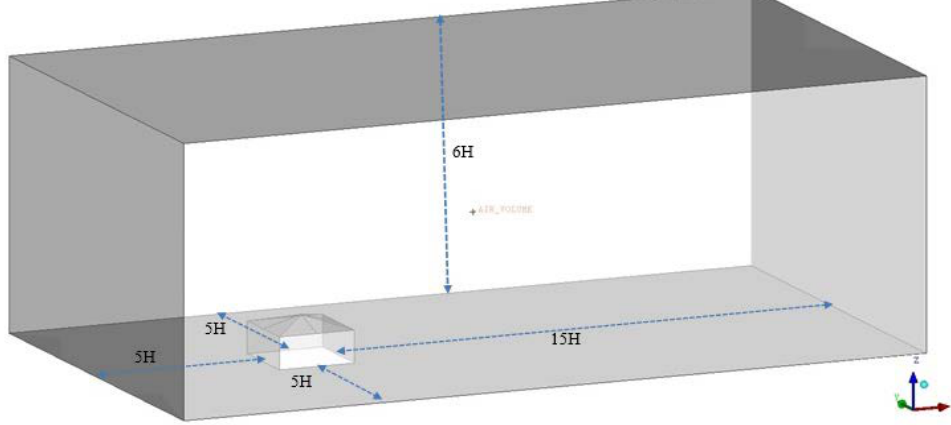
Fig. 3. Computational domain of the building models [42].